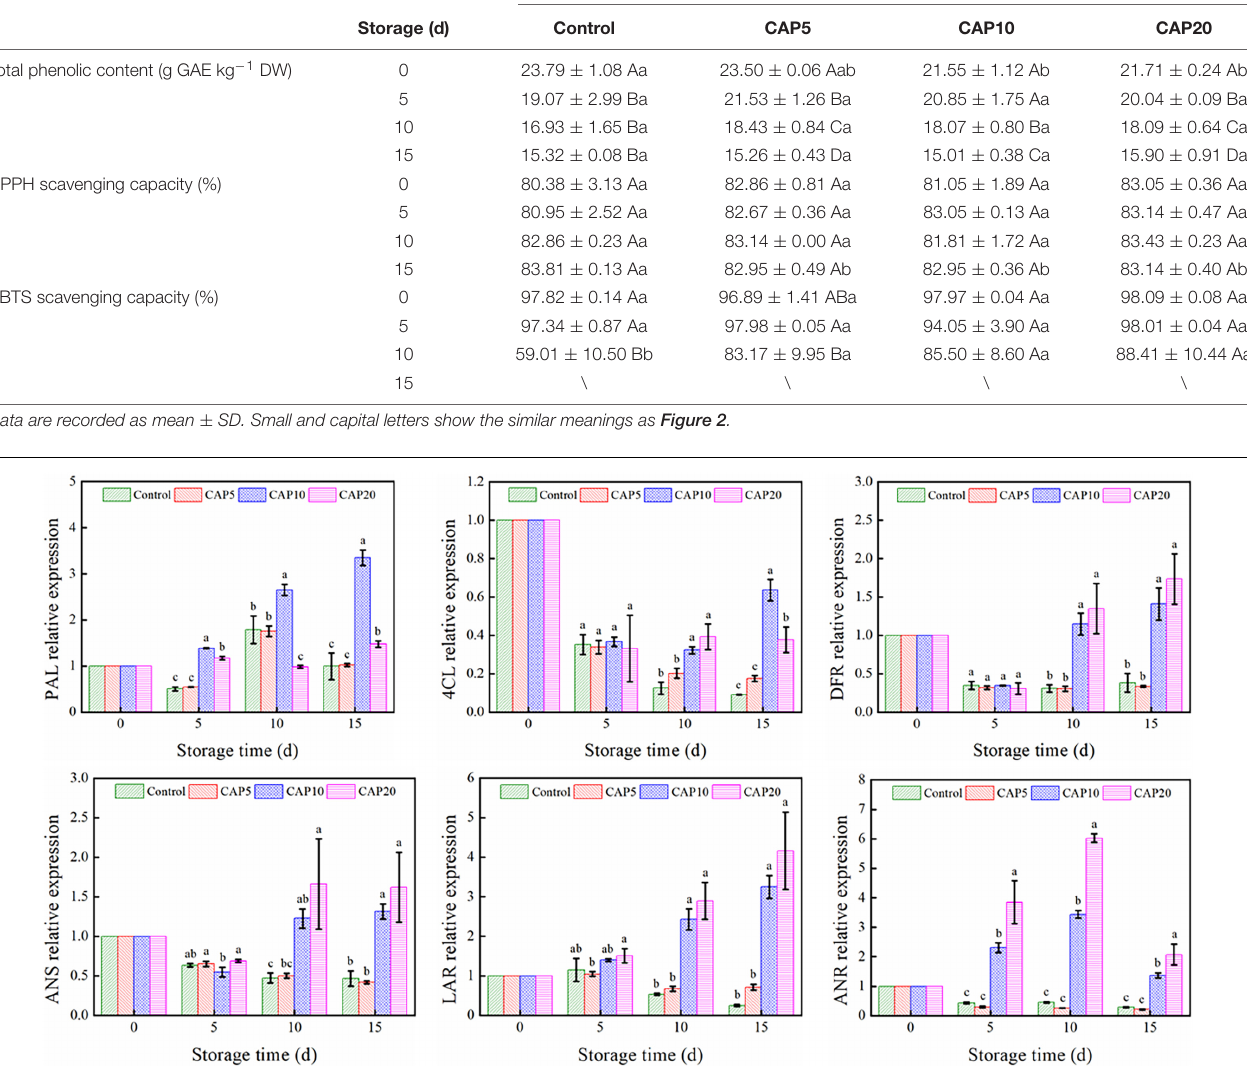
FIGURE 4 | Gene expression of jujubes in CAP5, CAP10, CAP20, and control during 15-day storage at 4 ◦ C and 90% relative humidity (RH). Different small letters indicate significant differences among different groups at the same storage time ( p <